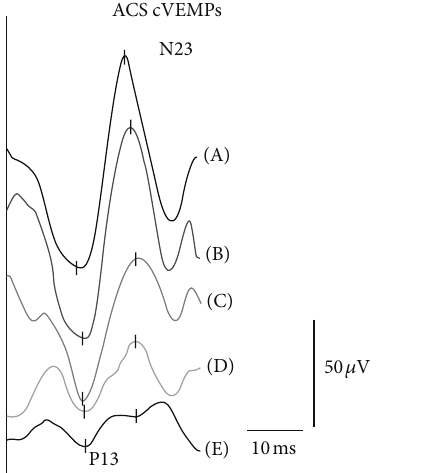
Figure 2: ACS cVEMP at 500Hz (100dBnHL) before (A) and after intratympanic gentamicin treatment from week 1 (B) to week 2 (C), week 3 (D), and week 4 (E).